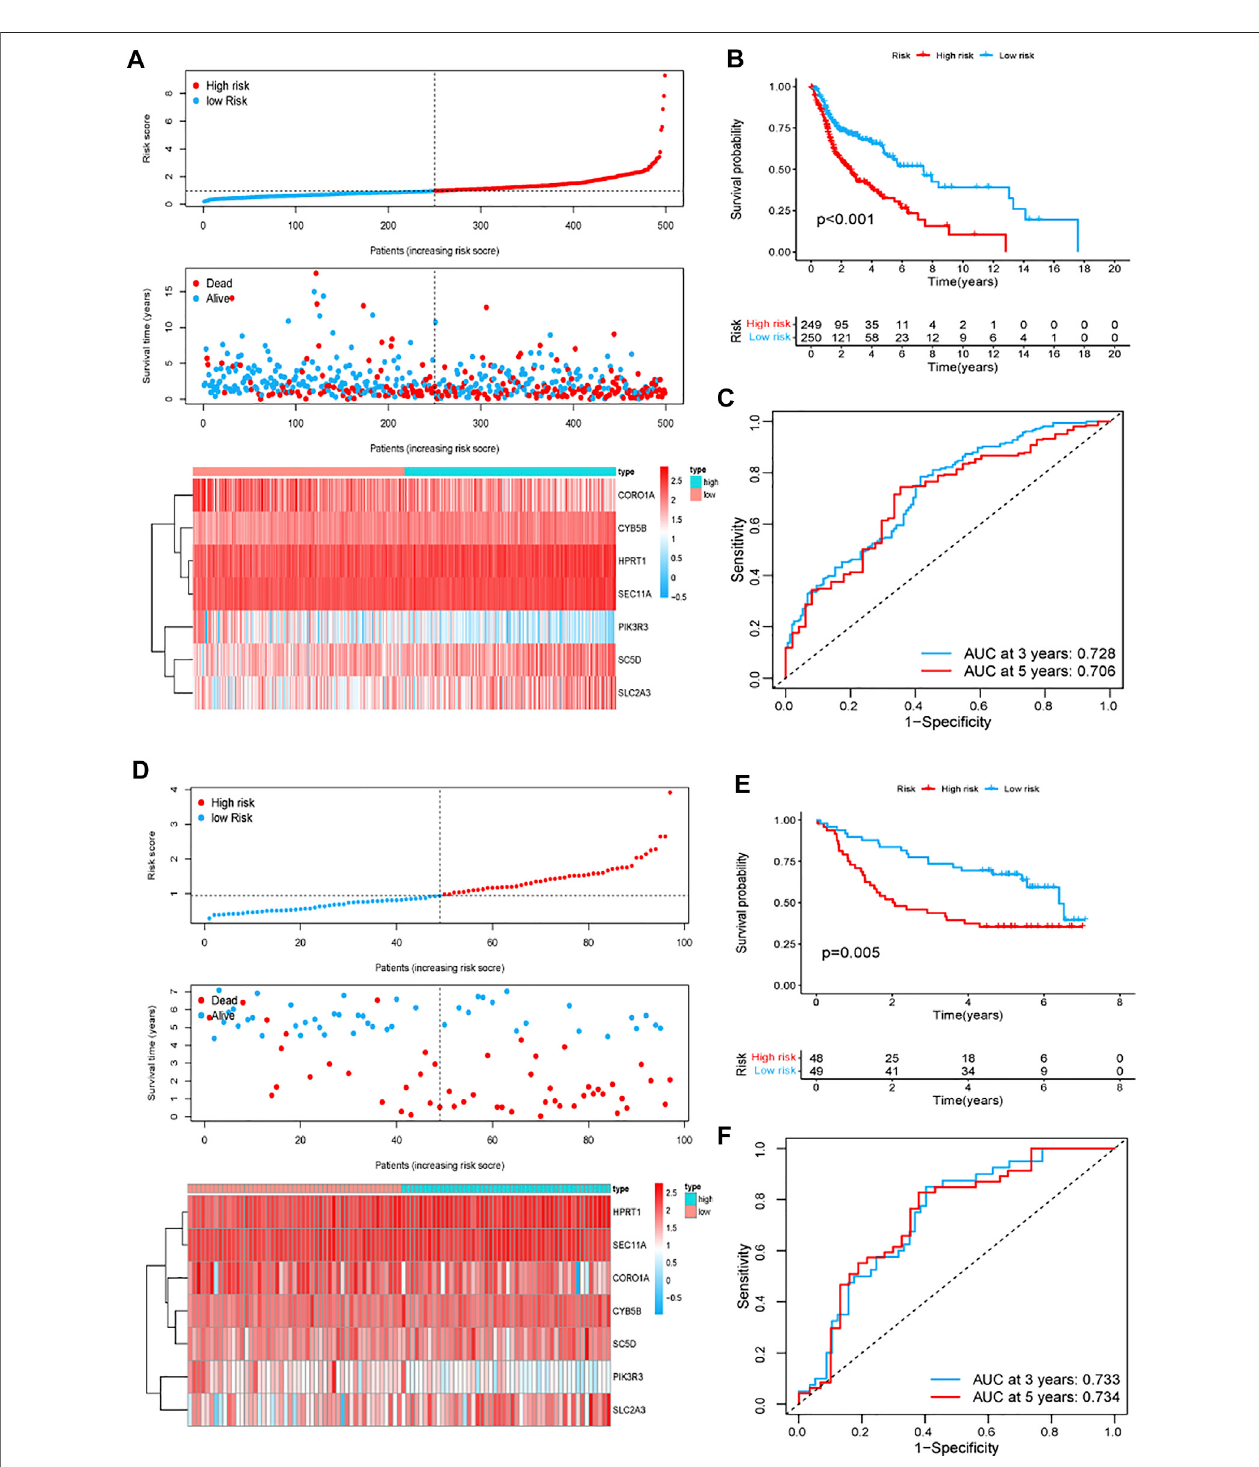
FIGURE 3 | Prognostic signature analysis ofpatients with HNSCC in TCGA and GEOGSE41613 cohorts. (A,D) Distributionsof the risk score, survival status, and the expression heatmap of the seven identi fi ed genes in the high- and low-risk groups in TCGA (A) and GEO GSE41613 (D) cohorts. (B,E) K – M curves for the two subgroups in TCGA (B) and GEO GSE41613 (E) cohorts. (C,F) ROC curve analysis for predicting the survival according to the risk score in TCGA (C) and GEO GSE41613 (F) cohorts.Abbreviations:GEOGSE41613,GeneExpressionOmnibusGSE41613cohort;HNSCC,headandnecksquamouscellcarcinoma;TCGA, The Cancer Genome